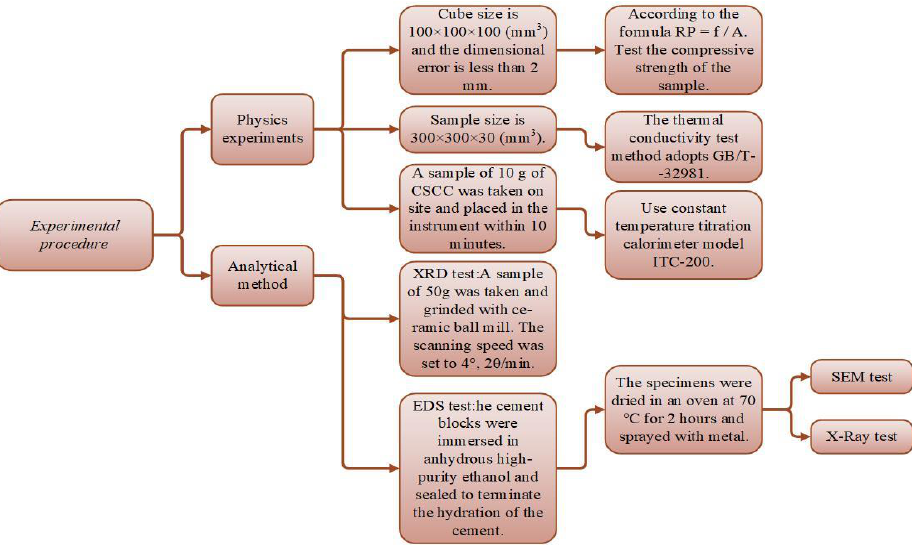
Figure 4. CSCC experimental procedure flow chart.